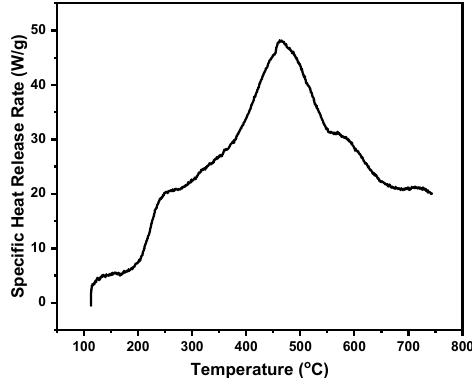
Figure 10. MCC curve of poly(CA-pdms-fu).